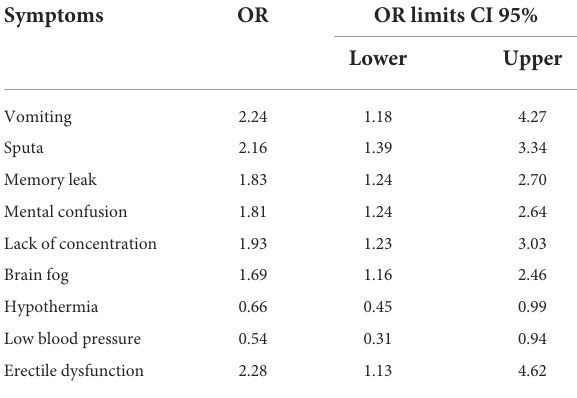
TABLE 6 Vaccination – symptoms of long